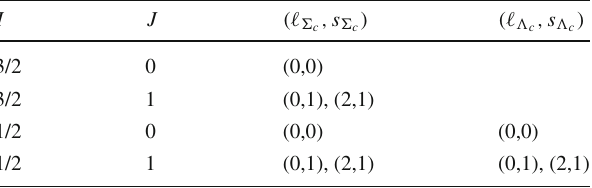
Table 2 (cid:3) c N channels ((cid:13) (cid:3) contribute to a given state with isospin I and total angular